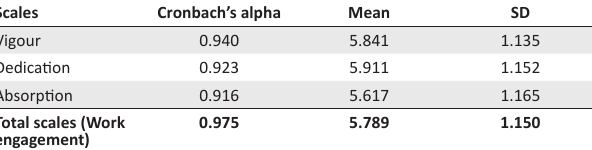
TABLE 3: Frequency distribution for Utrecht Work Engagement Scale. Scales